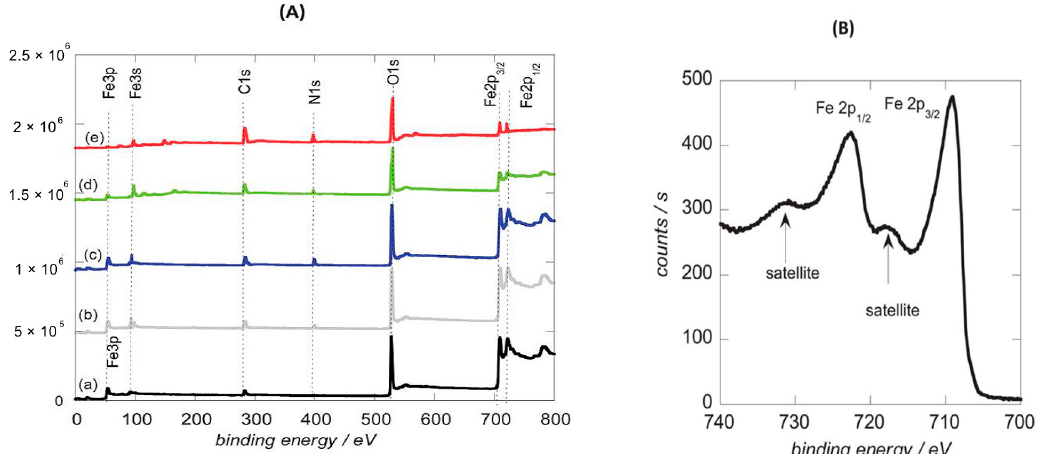
Figure 5. ( A ) X-ray Photoelectron Spectroscopy (XPS) survey spectra of as prepared magnetic particles before (a, black) and after modification with dopamine (b, grey), dopamine-N3 (c, blue), dopamine- MA (d, green), and of MF-MP (e, red). ( B ) High resolution Fe2p spectrum of as-synthesized magnetic particles. Reprinted with permission from Reference [125].